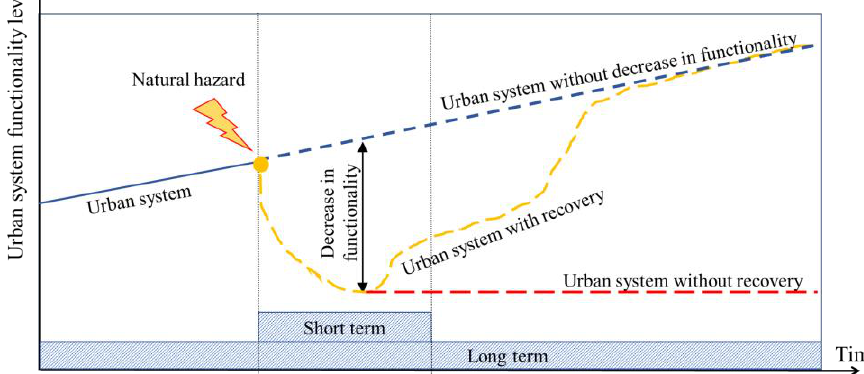
Fig. 2. Dynamic problem that study intends to solve (Urban system: Blue line; Urban system without loss of functionality level: Blue dotted line; Urban system with recovery: Orange dashed line; Urban system without recovery: Red dotted